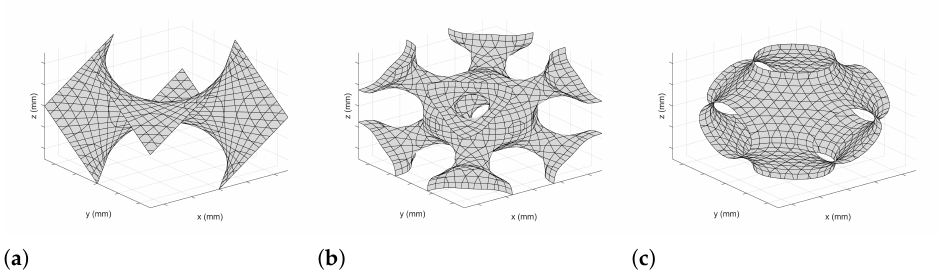
Figure 2. Thin-surfaced TPMS lattice designs: ( a ) Diamond cell, ( b ) I-WP Cell, ( c ) Primitive cell.